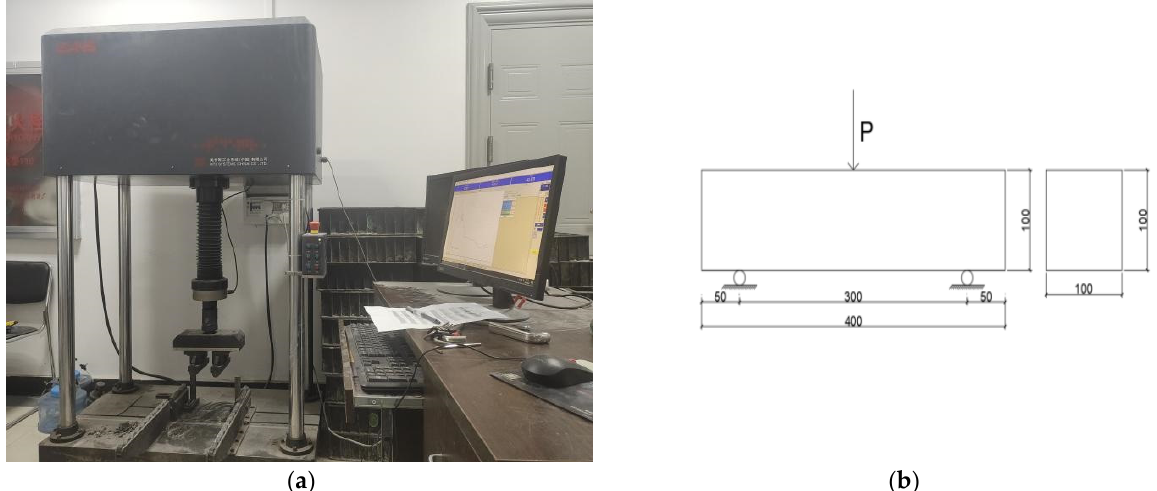
Figure 18. Flexural test equipment and loading device. ( a ) Test equipment. ( b ) Loading method arrange- ment.